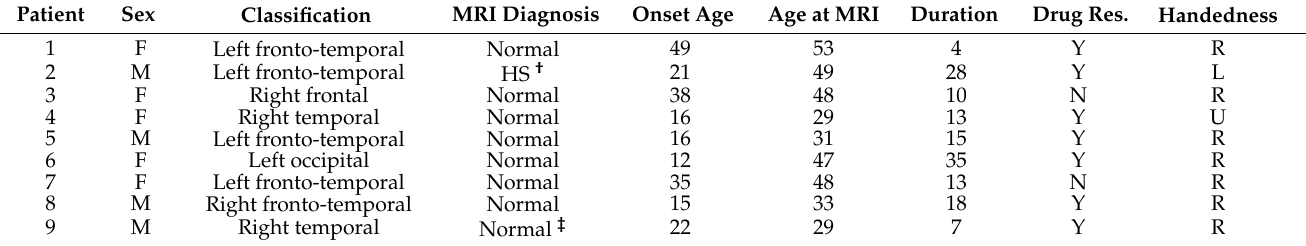
Table 1. Characteristics of